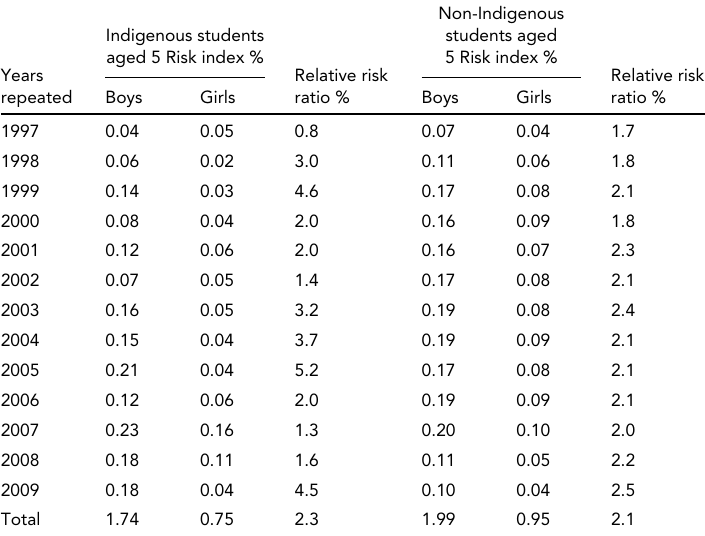
Relative Risk Ratios Calculated From the Risk Ratios of Both Indigenous Boys and Girls and Non-Indigenous Boys and Girls, Aged 5 Years Repeated in